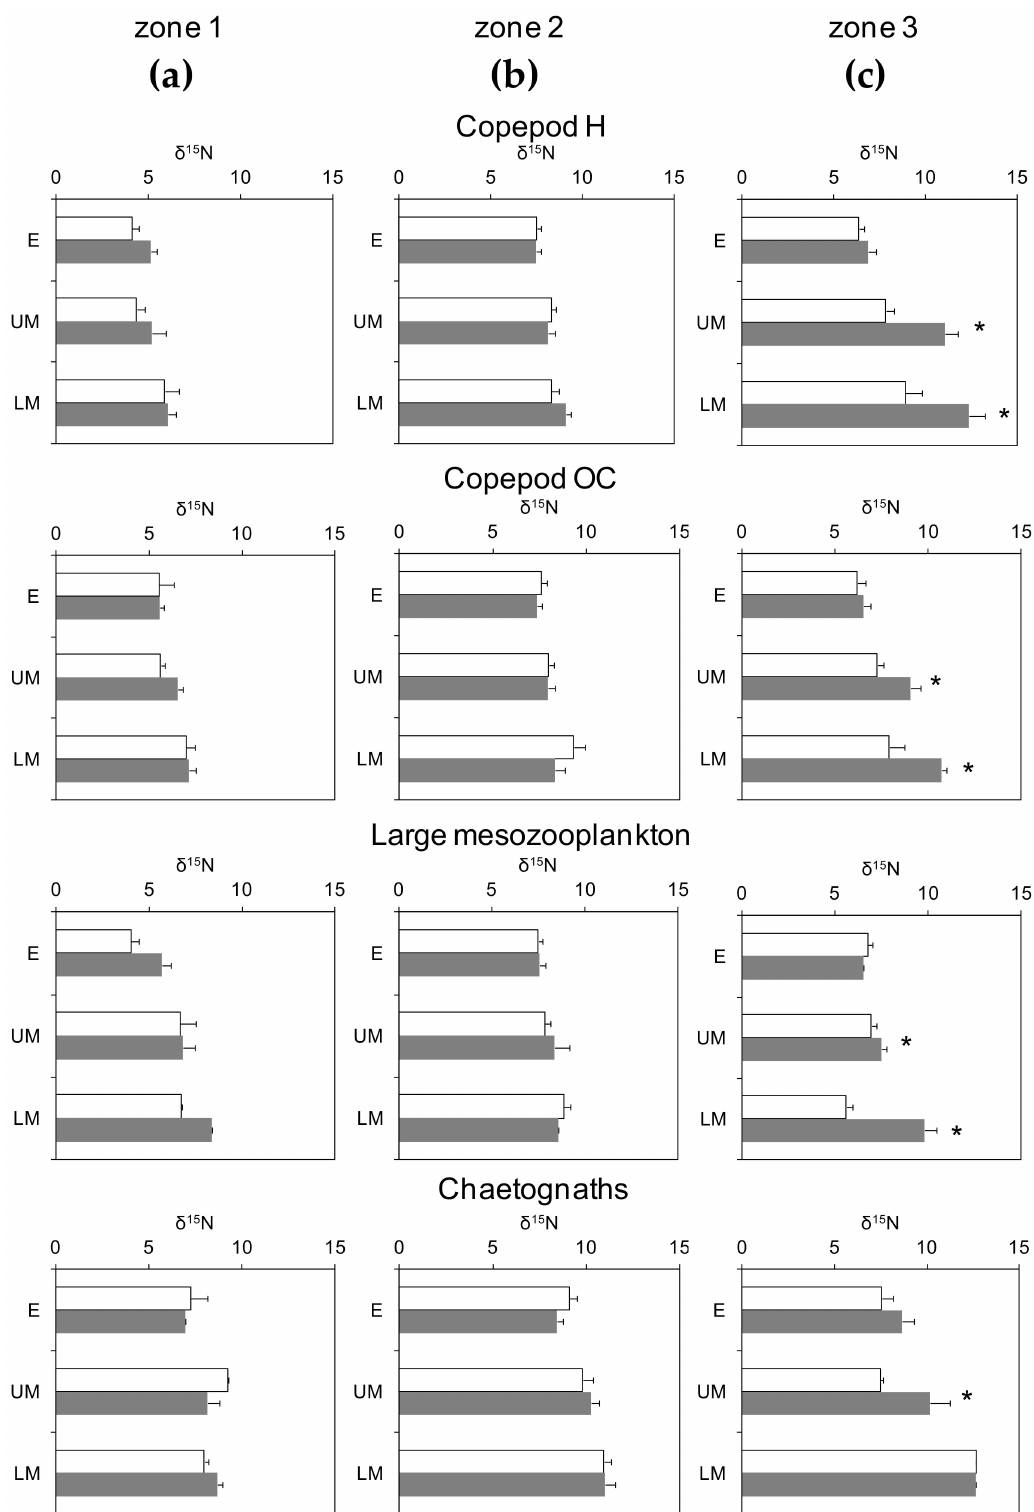
Figure 4. The mean ( ± se) δ 15 N of plankton guilds (H: herbivores, OC: omnivores-carnivores) for the epipelagic (E, 0–200 m), upper mesopelagic (UM, 200–500 m), and lower mesopelagic (LM, 500–900 m) layers in ( a ) zone 1, ( b ) zone 2 and ( c ) zone 3 for day (white bars) and night (grey bars) samples. Asterisks indicate significant differences (ANOVA, p < 0.05) between day and night samples at each